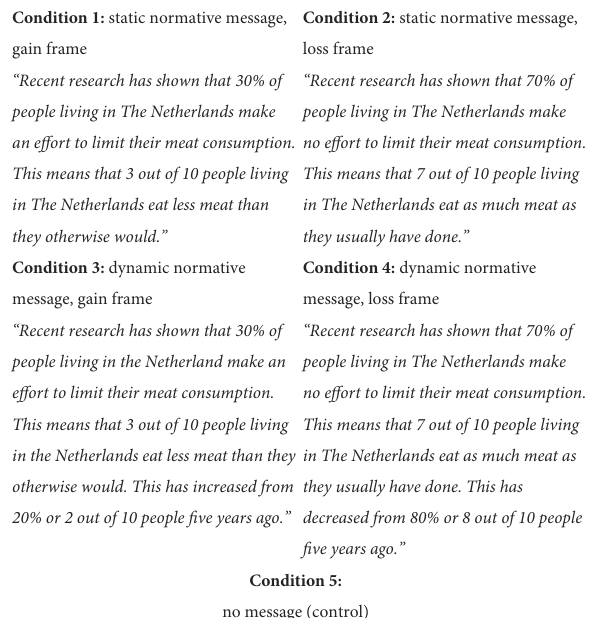
TABLE 2 One-way between-subject experimental design: the five experimental conditions. General